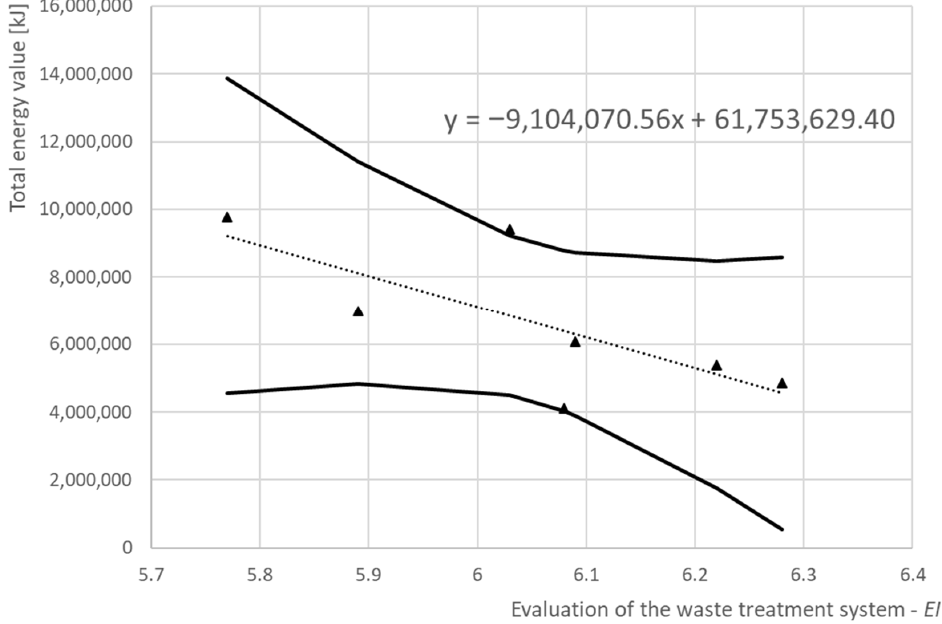
Figure 10. Regression curve describing the effect of the rating on RDF energy quality.